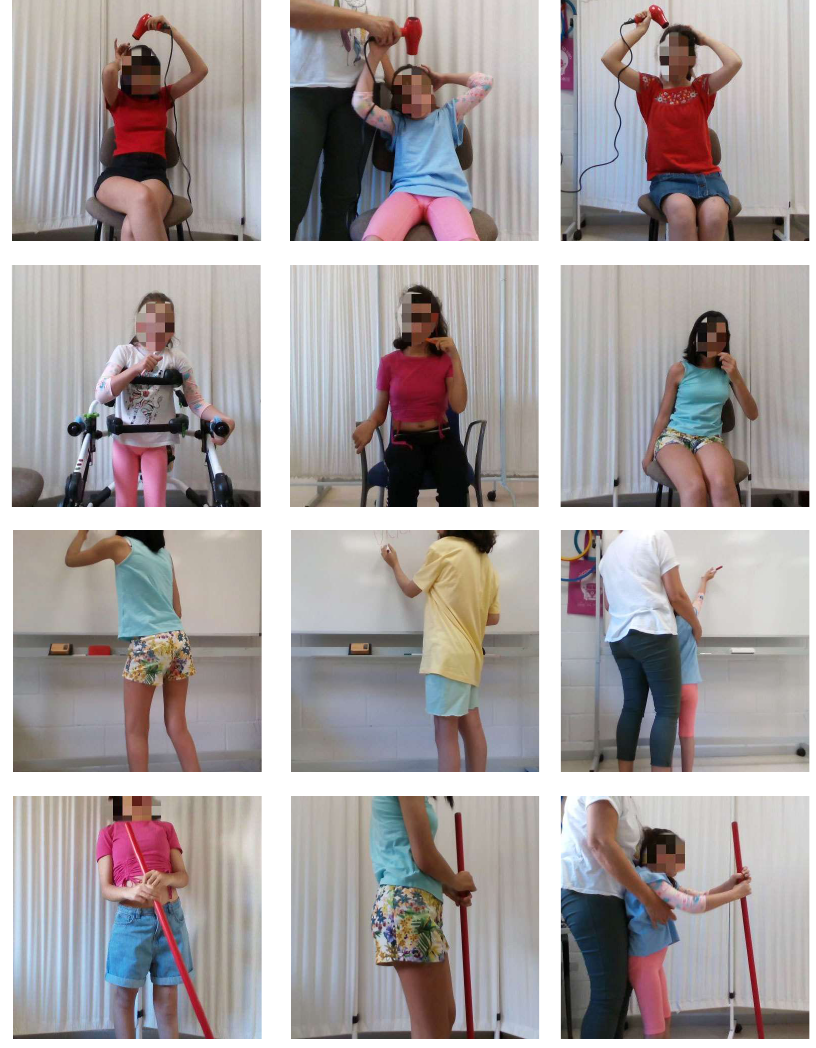
Figure 8. This figure includes images of several participants during the interventions performing the four study actions: blow-drying hair ( first row ); brushing teeth ( second row ); writing on a blackboard ( third row ); and mopping ( fourth row